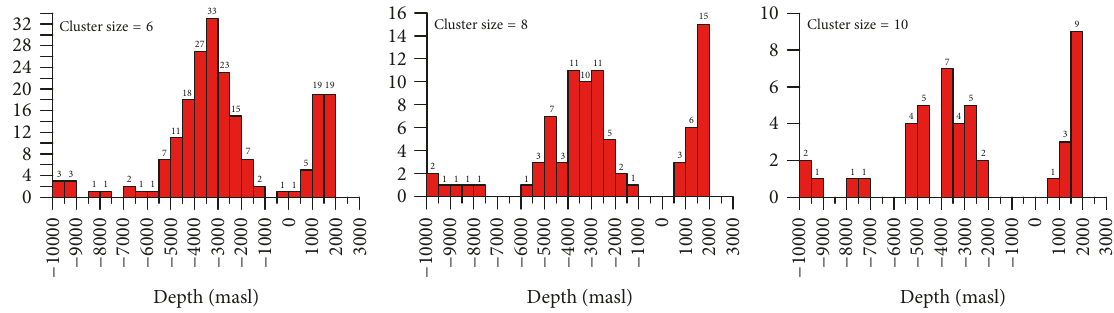
Figure 31: Histograms of the Frac-Digger sensitivity of the estimated depths of dikes to the cluster size (or the number of events in cluster 𝑁 ).